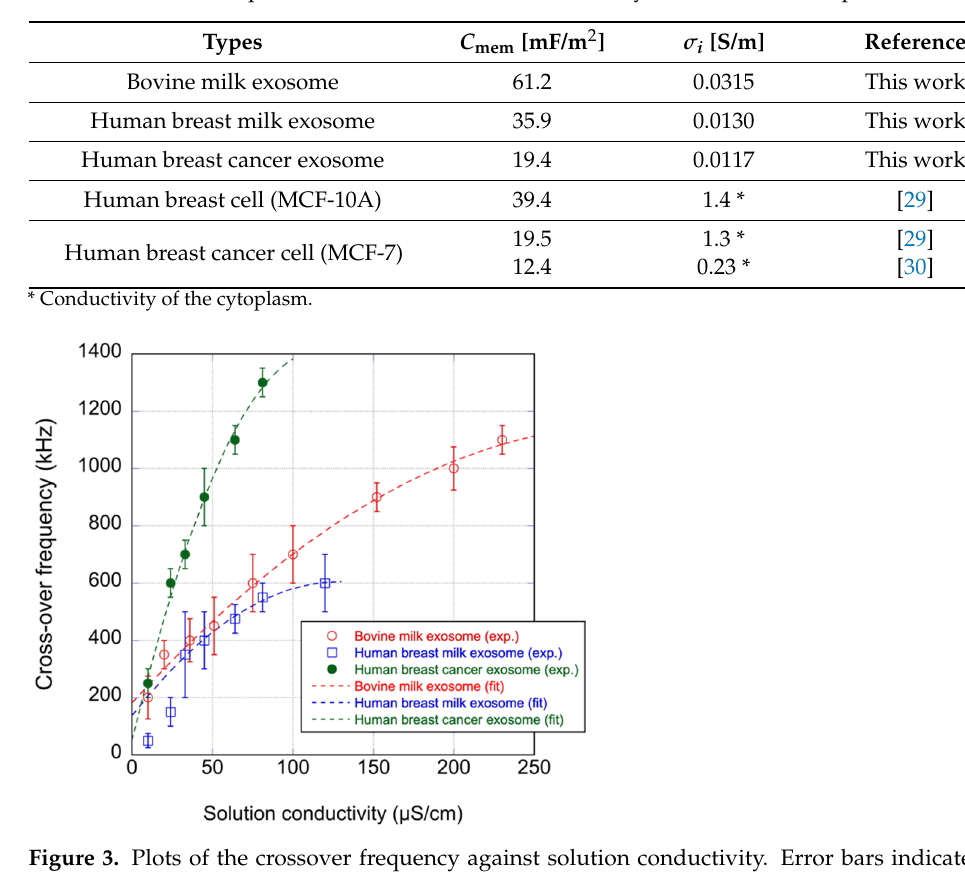
Table 1. Membrane capacitance, C mem , and inner conductivity, σ i , of exosome samples.